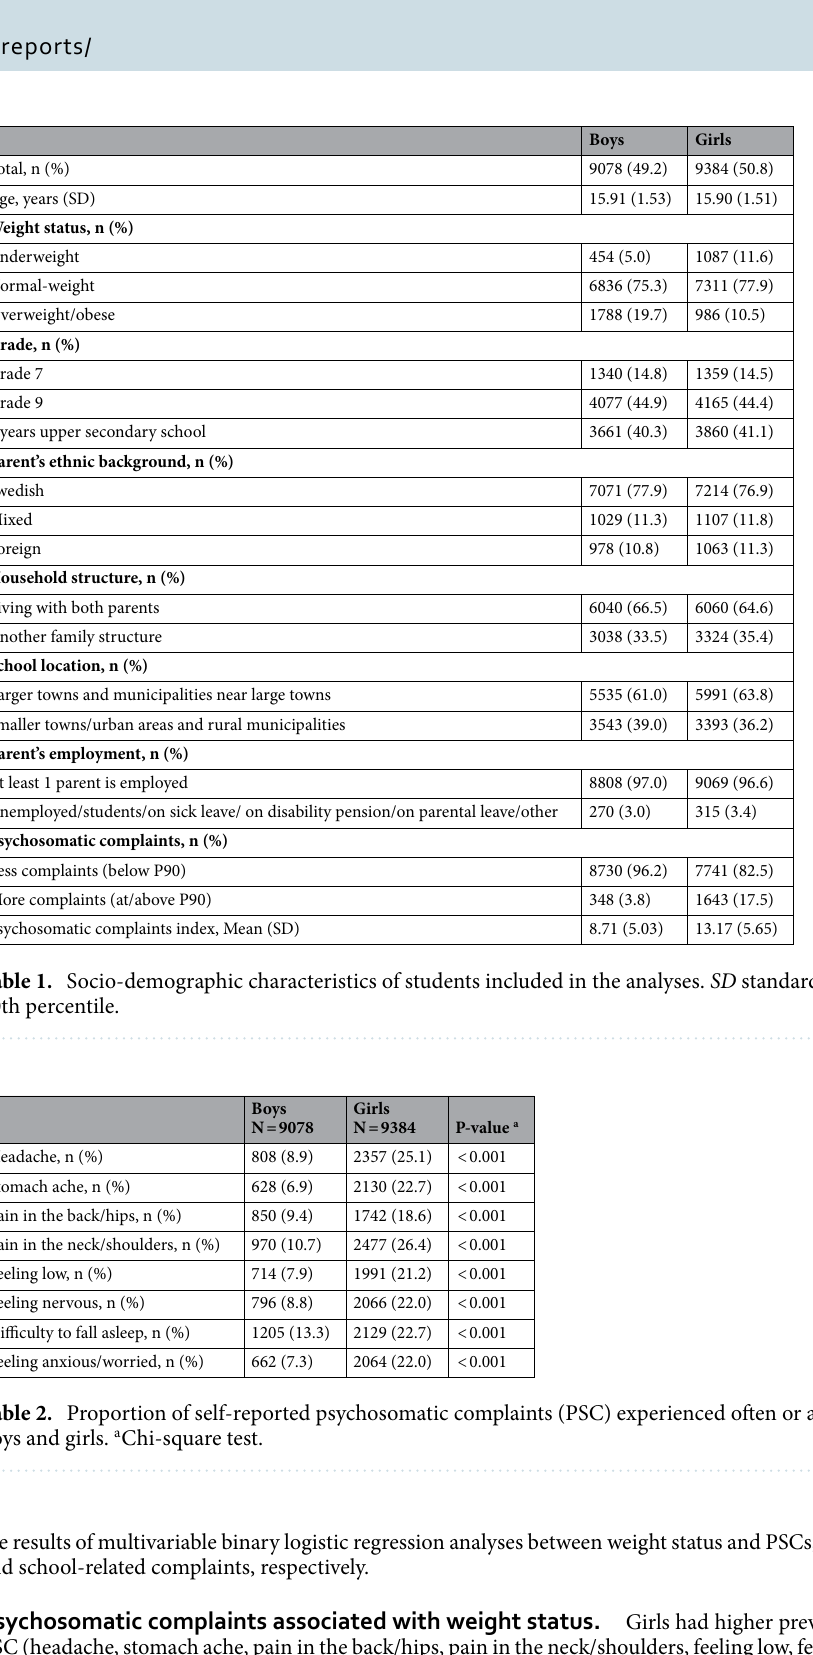
structure, parents’ employment status, year of survey and school location, revealed that underweight boys had a higher odds ratio for all eight PSC with odds ratios (OR) ranging from 1.44 to 1.84 than normal-weight boys (Table 3). Overweight/obese boys reported more often headache, pain in the back/hips, and feeling low com-